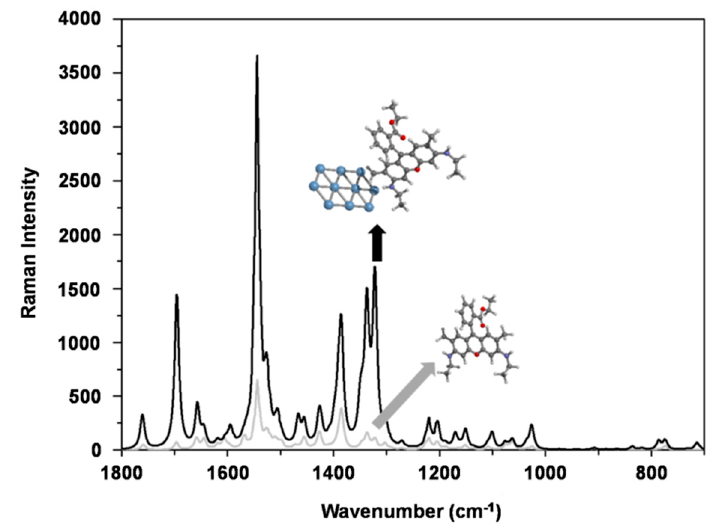
Figure 3. DFT calculation of R6G alone (grey line) and R6G interacting with a thin layer of 10 atoms of Ag (black line). The Ag layer causes a SERS effect leading to an increase in Raman signal intensity of one order of magnitude.